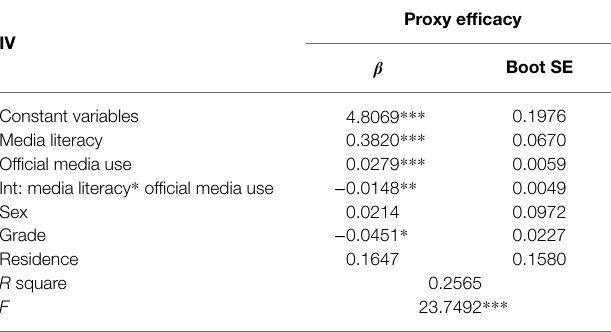
TABLE 5 | The moderation effect of official media use between media literacy and proxy